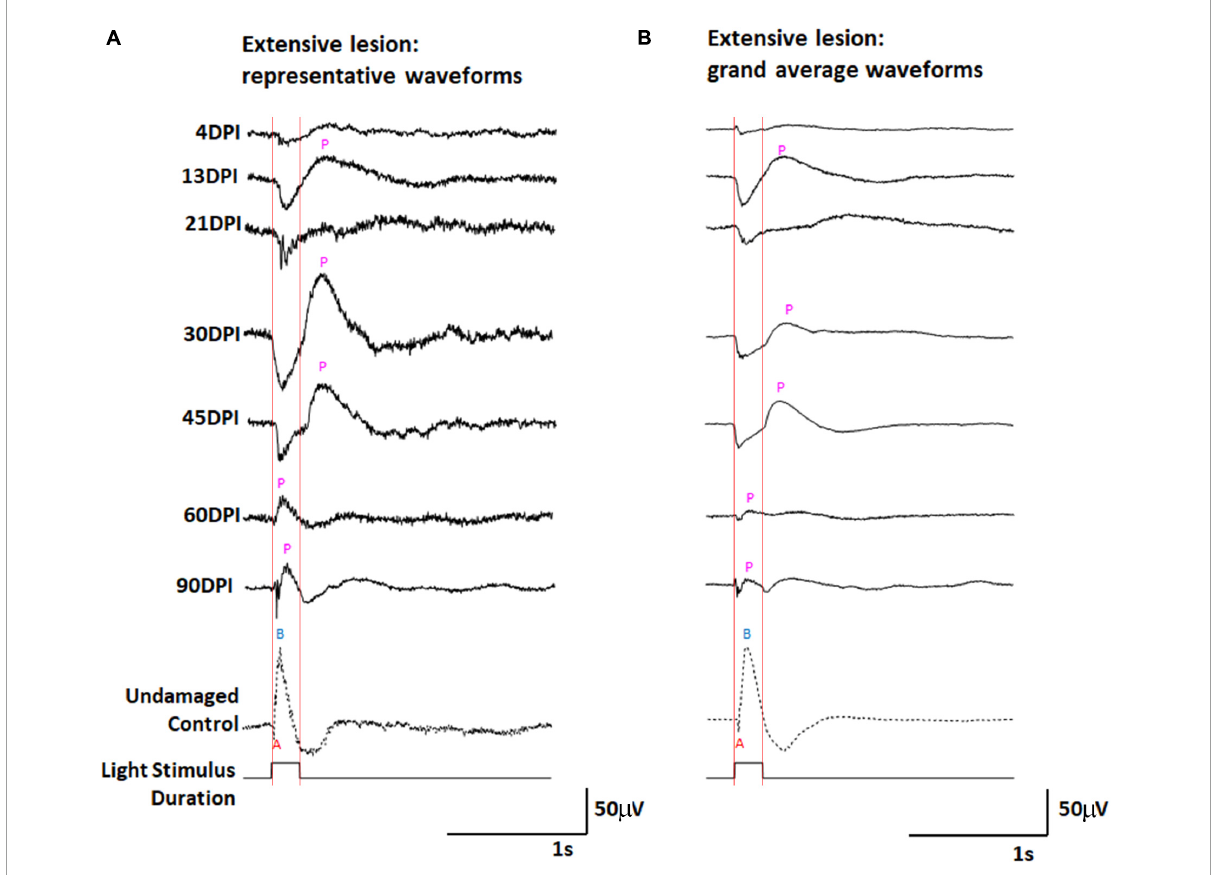
FIGURE1 ERG waveforms in response to a 200 ms light flash, over an extended time-course of retinal regeneration following an extensive ouabain lesion. (A) Representative waveforms. (B) Grand average waveforms. A, a-wave; B, b-wave; P, post-photoreceptor response (PPR); DPI, days post-injury. Red vertical lines were added to this figure to facilitate comparison of traces in the context of light onset and